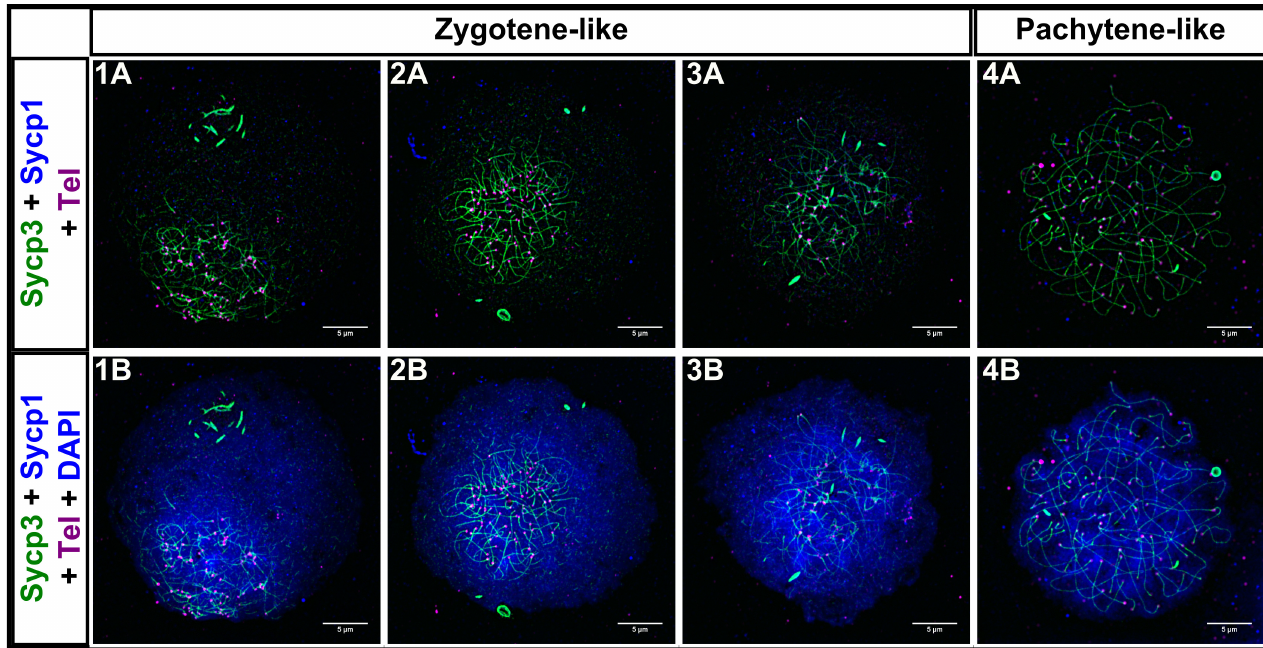
Fig 9. spo11 -/- females fail to properly synapse homologous chromosomes. 1A-4B: spo11 -/- nuclear surface spreads stained for Sycp3 (green), Sycp1 (blue), telomeres (Tel; magenta), and DNA (DAPI, blue). While Sycp3 loading proceeds, chromosomes are not synapsed. Scale bar = 5 μ m).